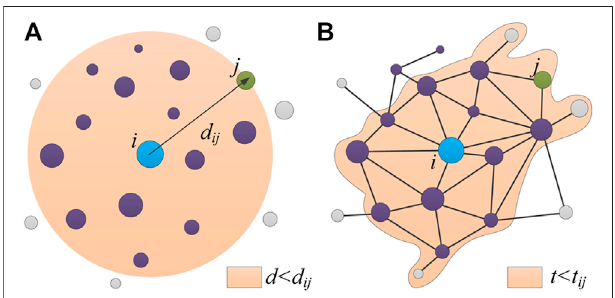
FIGURE 1 | Schematic diagram of the calculation of intervening opportunities.Eachdotrepresentsalocation.Location i (bluedot)istheorigin, and location j (green dot) is the destination. (A) In the OPS model, the intervening opportunity s ij refers to the sum of the number of opportunitiesatalllocations( i.e. ,locationsintheorangecircle,exceptlocation i and location j ) whose distance d from location i is less than the distance d ij from location i to location j . (B) In the ICC model, intervening opportunity s ij refers to the sum of the number of opportunities at all locations ( i.e. , locations in the orange area, except location i and location j ) whose travel time t from location i is less than the travel time t ij from location i to location j , where the travel time is obtained by calculating the shortest travel time path through the transportation